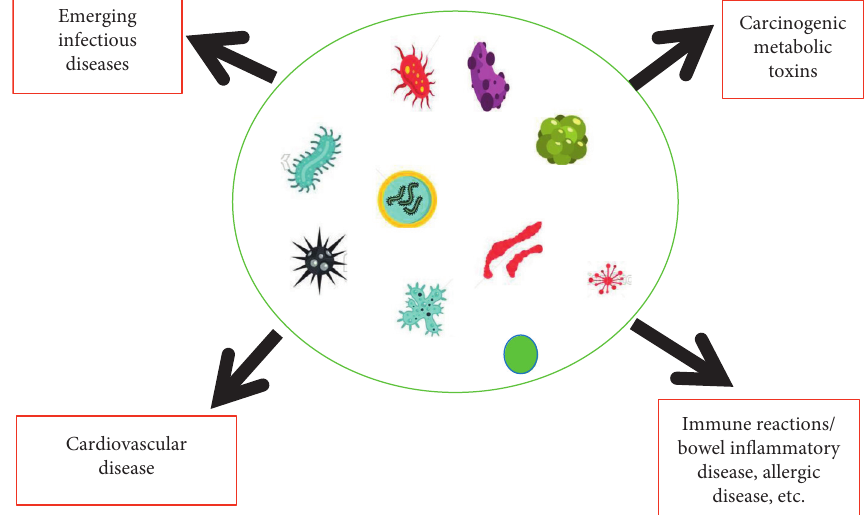
Figure 1: Dysbiotic flora and its impact on human health. Carcinogenic metabolic toxins produced from dysbiotic flora may trigger the progression of cancer and immune reaction in the gastrointestinal tract. In addition, hepatic oxidation of trimethylamine to trimethylamine N-oxide contributes to cardiovascular and emerging